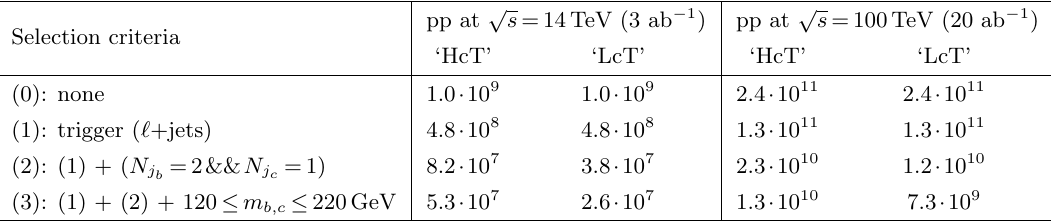
Table 10 . Total number of events expected for t (cid:22) t ! N j + ‘ (cid:6) + X with ‘ (cid:6) = (cid:22) (cid:6) ; e (cid:6) , in pp p collisions at s = 14 and 100 TeV, passing the analysis criteria for the ‘HcT’ and ‘LcT’ charm jet reconstruction performances discussed in the text. The \trigger" row lists the number of events that pass the trigger cuts presented in subsection 3.1.2, and ( N j exact requirement of two b - and one c -quark jets reconstructed in the event with the kinematic criteria discussed in the text.